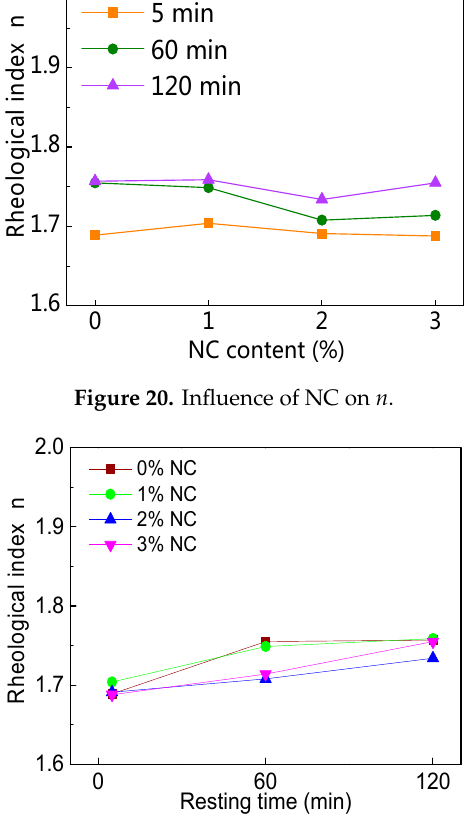
Figure 21. Influence of resting time on n.